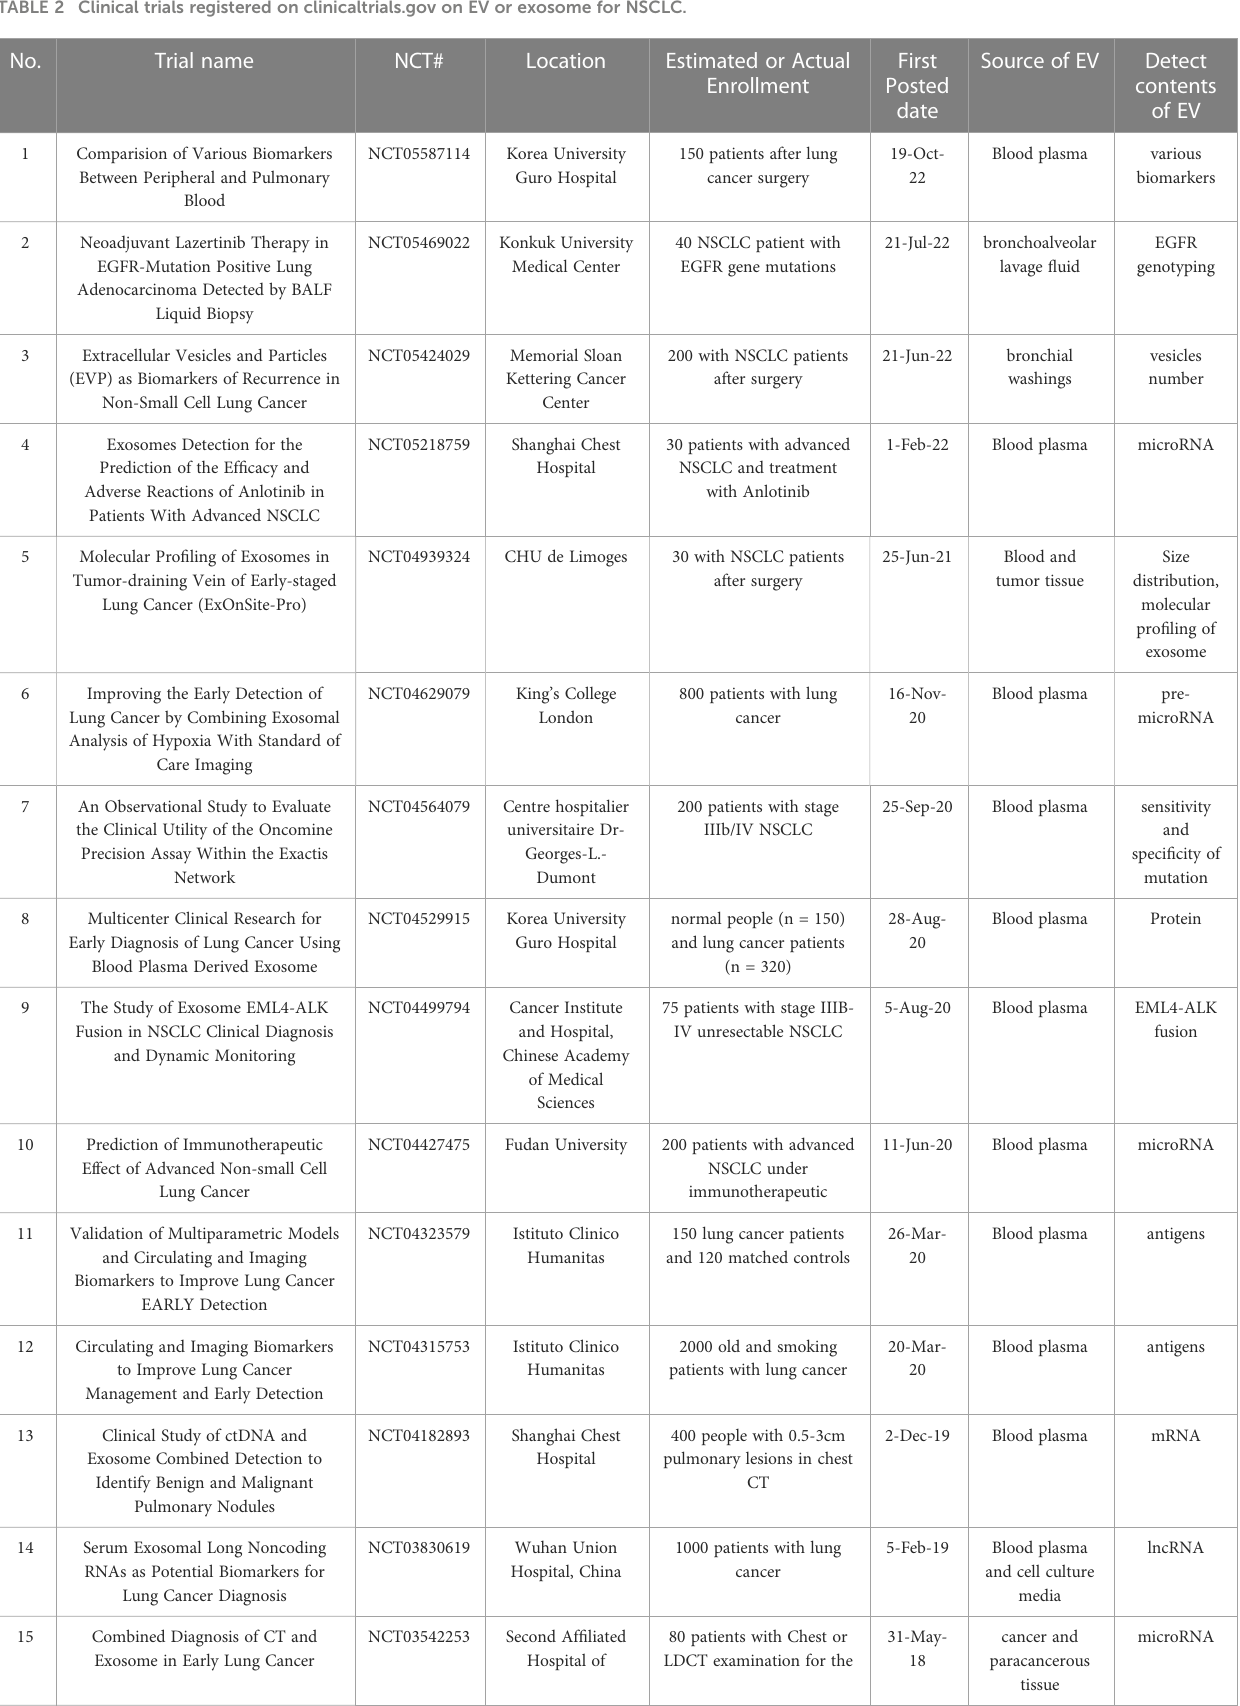
TABLE 2 Clinical trials registered on clinicaltrials.gov on EV or exosome for NSCLC.